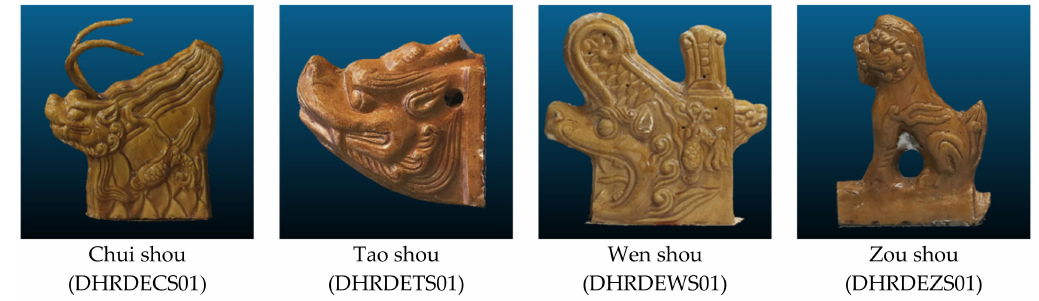
Figure 12. Experimental component objects.